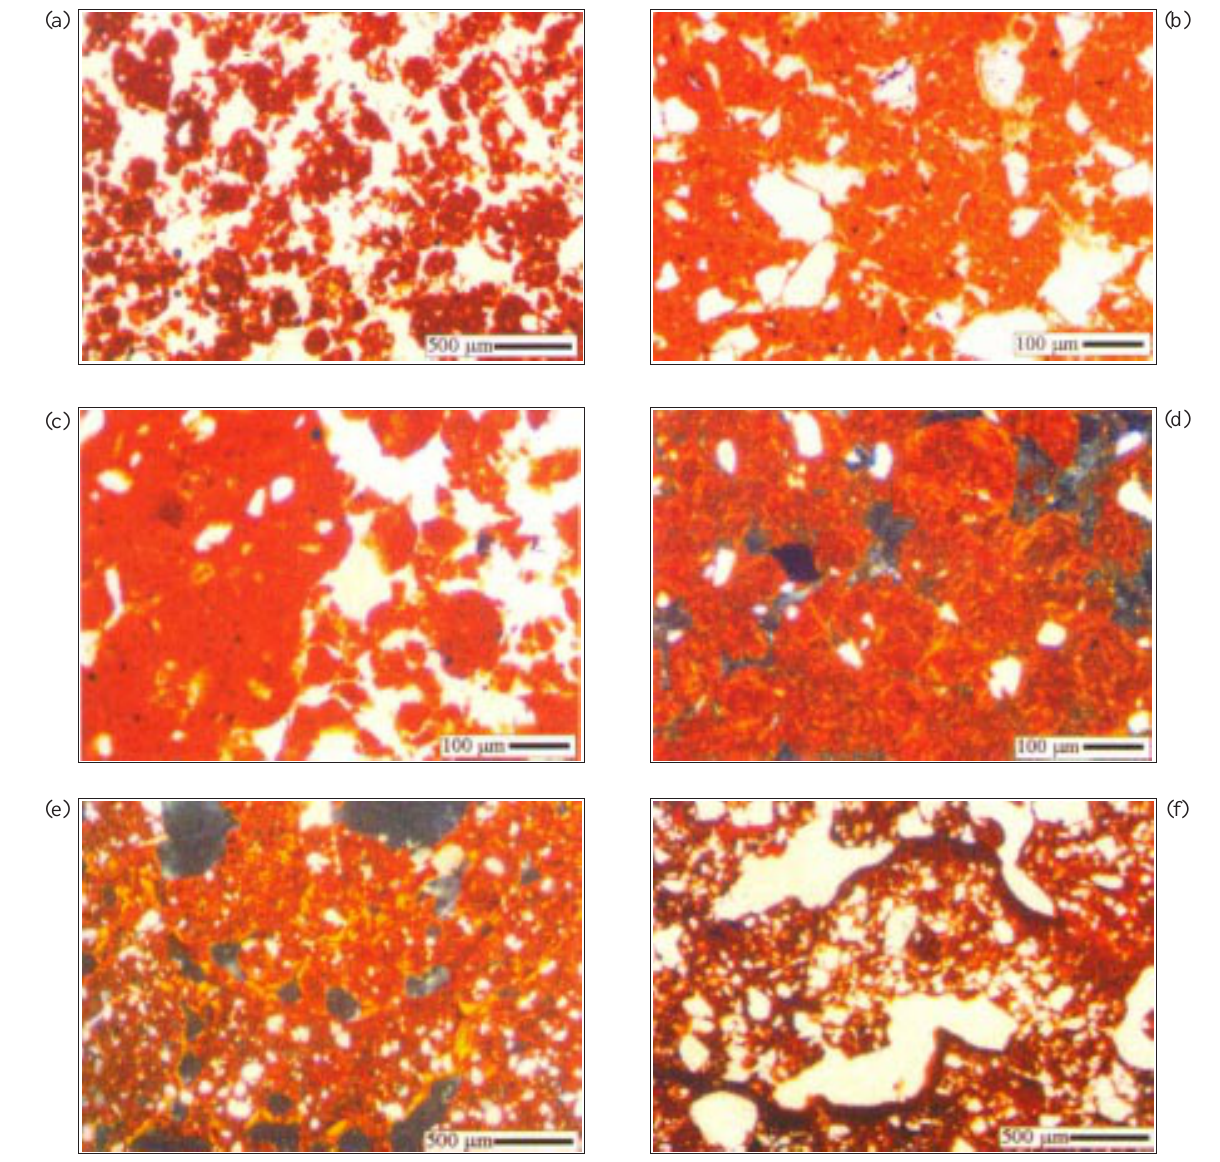
Figura 3. Fotomicrografias dos perfis 1 e 5: (a) horizonte Bw do perfil 1 com trama grânica; (b) horizonte BA (80-90 cm) do perfil 1 com empacotamento de microagregados (trama apórica granóidica); (c) fragmentação de agregado centimétrico denso em microagregados no horizonte Bw próximo ao 2BC do perfil 1 (600-610 cm); (d) material porfírico do horizonte Bw do perfil 1 (600-610 cm) com malha de zonas estriadas onde os microagregados se individualizam preferencialmente (nicóis cruzados); (e) trama porfírica com cavidades do horizonte Bt1 (103-110 cm) do perfil 5; distribuição dos ferriargilãs mostra coalescência de microagregados por argiluviação; (f) transição A/Bt do perfil 5; trama porfírica com coalescência de cavidades cujas paredes inferiores estão revestidas por ferrãs de